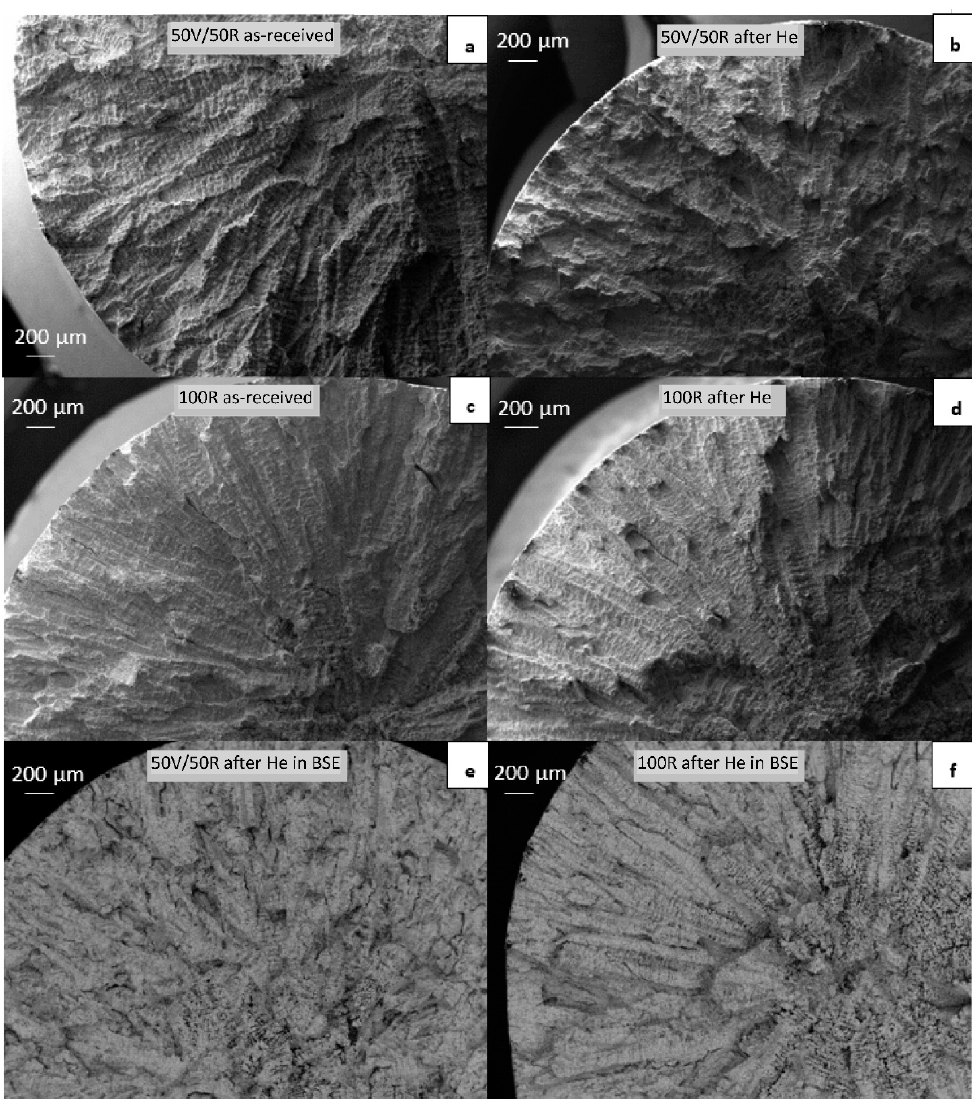
Figure 10. SEM–BSE micrographs of fractures in tensile specimens: ( a ) 50R as-received; ( b ) 50R after He exposure; ( c ) 100R as-received; ( d ) 100R after He exposure; ( e ) 50R after He exposure in BSE; ( f ) 100R after He exposure in BSE contrast.